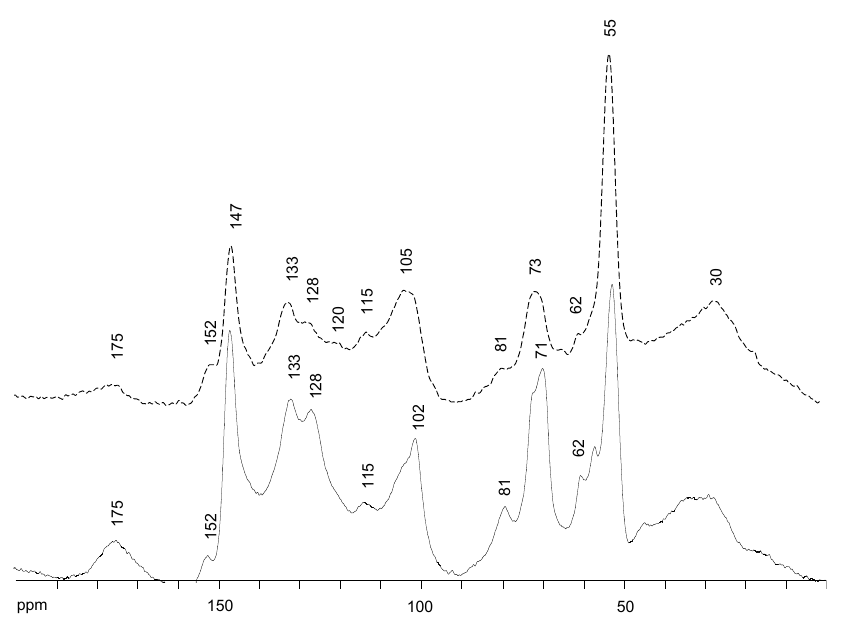
Figure 2. 13 C NMR spectra, δ C 200.0–0.0 ppm, of soda/AQ-orange lignin (discontinuous line) and soda/AQ-olive lignin (continuous line).